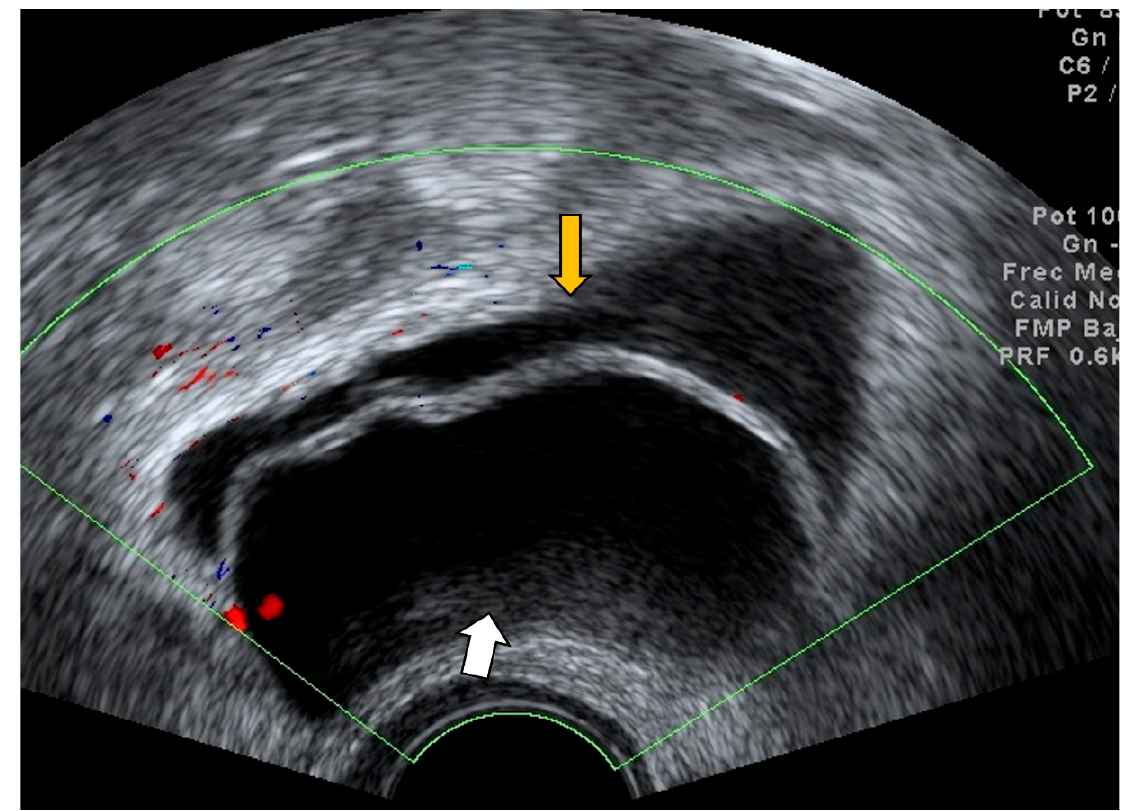
Figure 13. Ultrasonographic image of ureterocele showing an anechoic cyst (white arrow) within the posterior aspect of the urinary bladder (yellow arrow).